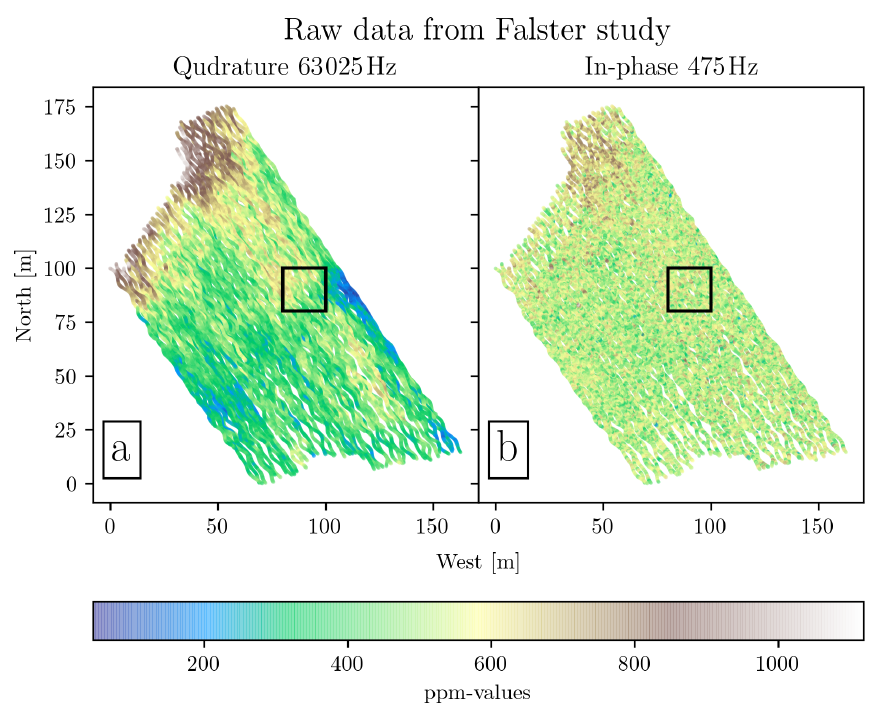
Figure 8. Falster drone-towed CSEM survey. The survey was carried out in T mode. In (a) quadrature 63025Hz is shown, and in (b) in-phase response at 475Hz for quadrature is shown. The black box outlines the sub-area in Fig. 9.